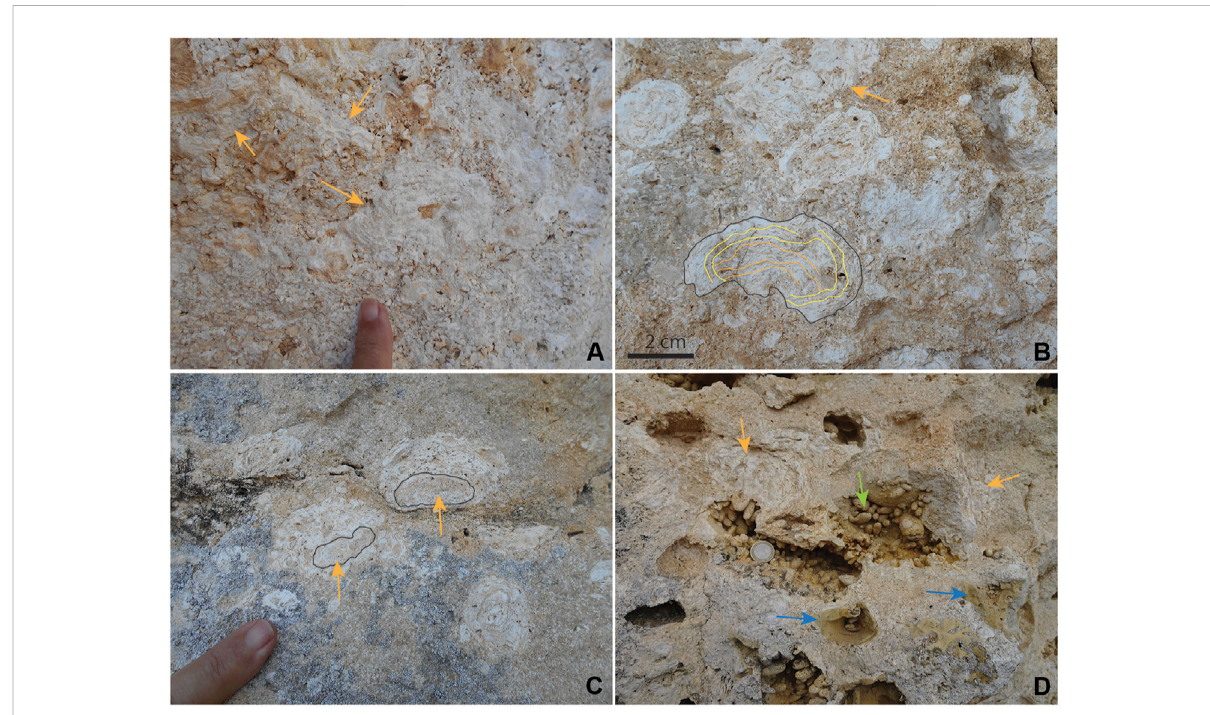
FIGURE 3 Field pictures of rhodoliths and lithoclasts in the Acinipo limestone. (A) Broken rhodoliths (arrows) in the trough cross-bedded rhodolith rudstone. Maximum fi nger width is 2 cm. (B) Broken rhodolith (arrow) and rhodolith with three phases of growth and fragmentation outlined in the trough cross-bedded rhodolith rudstone. (C) Asymmetrical rhodoliths with an initial growth phase outlined (arrows) in the trough cross-bedded rhodolith rudstone. Maximum fi nger width is 2 cm. (D) Broken rhodoliths (orange arrows) and lithoclasts in the massive rhodolith – lithoclast rudstone. Some lithoclasts partly preserve the original marly limestone composition (blue arrows). In most cases, the original marly limestone is leached/eroded, and only Gastrochaenolites borings fi lled with rudstone/packstone are preserved (green arrow). The coin diameter is 2.3